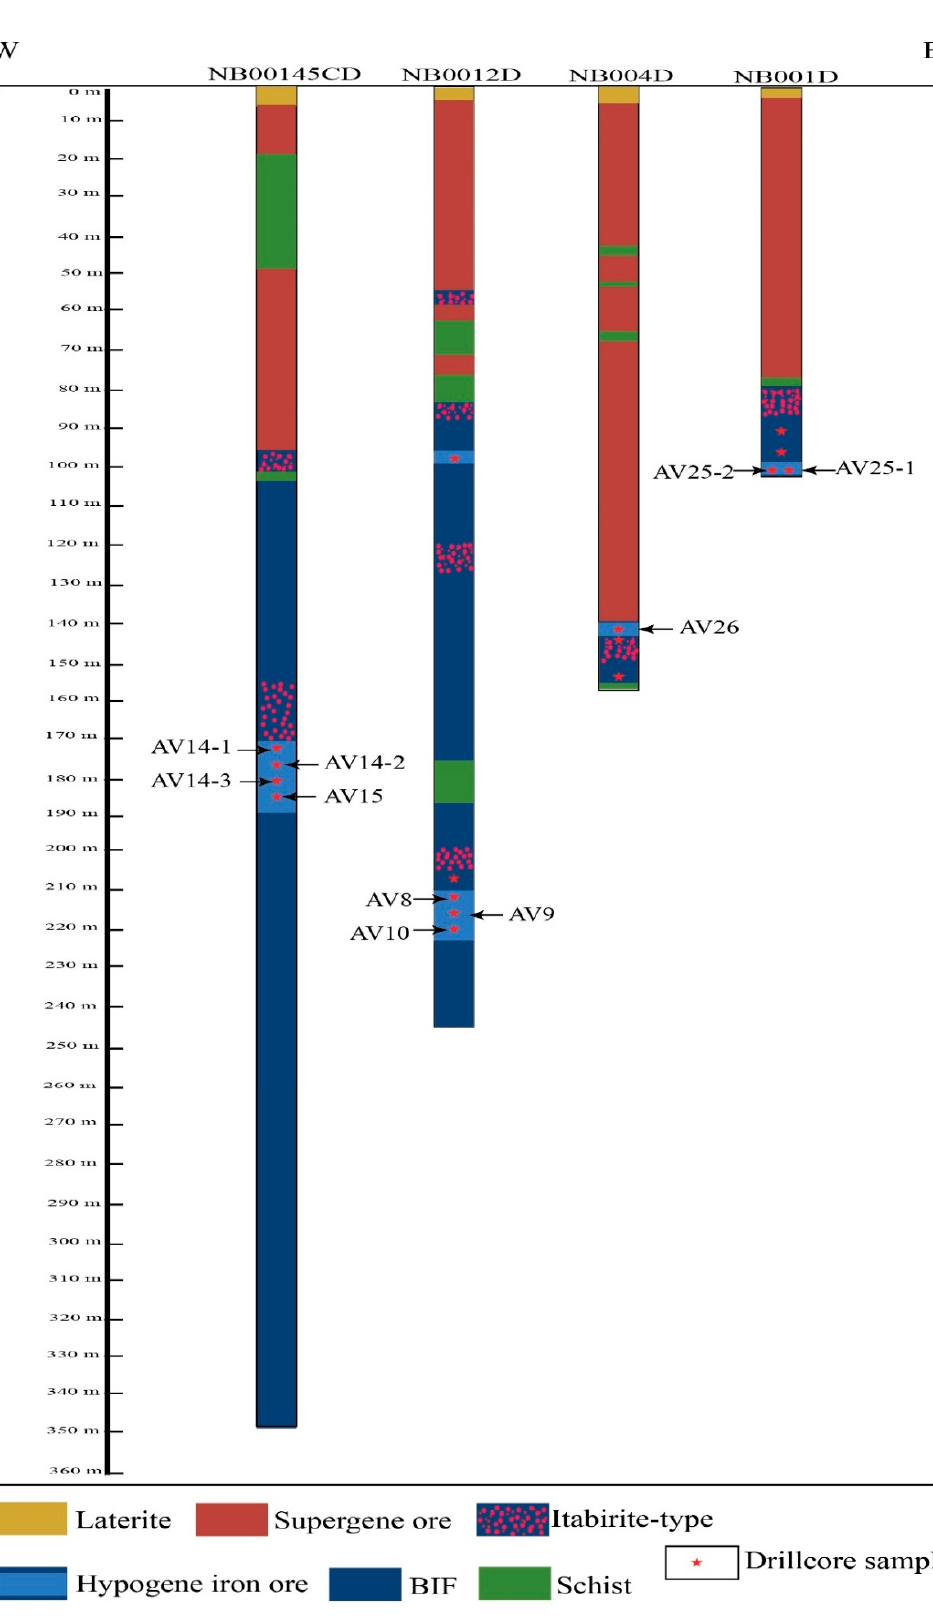
Figure 4. Geologic sketch of representative drill cores that intersected hypogene iron ore associated with quartz veins in the Nabeba deposit. Abbreviations: AV (number), Associate quartz vein; BIF, banded iron formation.